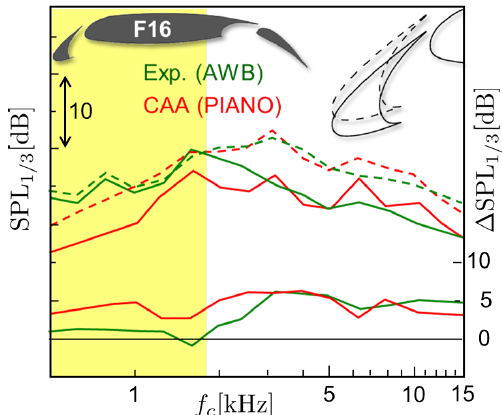
Figure 5. Slat noise prediction and comparison with AWB experimental data including slat setting variation; dashed lines correspond to reference slat setting, solid lines refer to low noise slat setting. Right hand scale referring to spectral difference. Yellow shade area contaminated by wind tunnel background noise